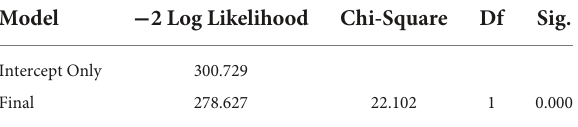
TABLE 5 Model fitting